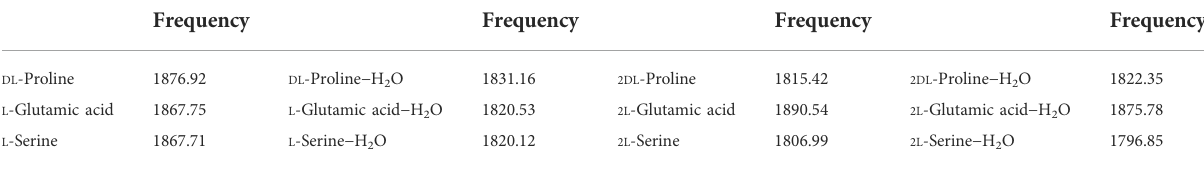
TABLE 6 Calculated frequencies of v (C=O) (cm − 1 ) for the amino acids, amino acids with water complexes, and amino acid dimer complexes. Frequency Frequency Frequency